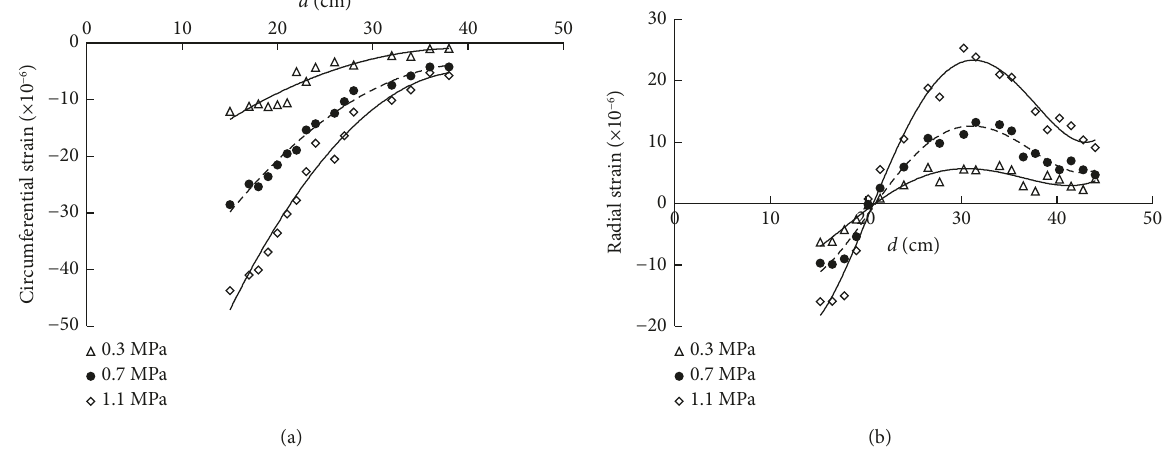
Figure 19: Strain test results of the AC pavement structure model under the different load levels. (a) Circumferential strain. (b) Radial